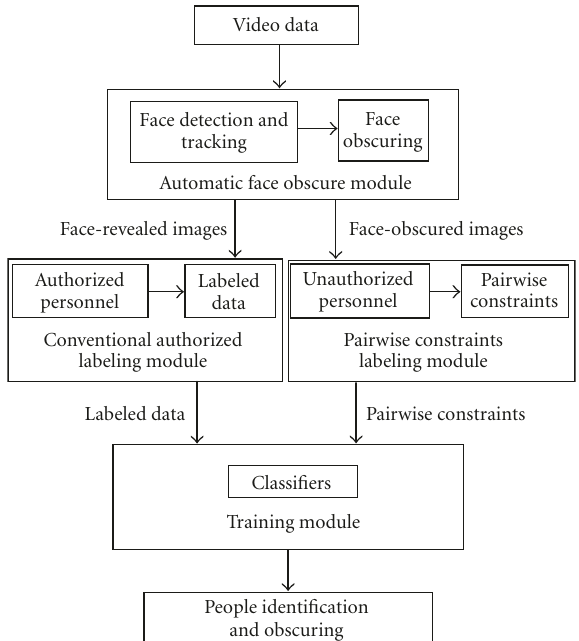
Figure 1: The proposed approach consists of four modules: au- tomatic face obscuring module, conventional authorized labeling module, pairwise constraint labeling module, and training module, and appearance obscures